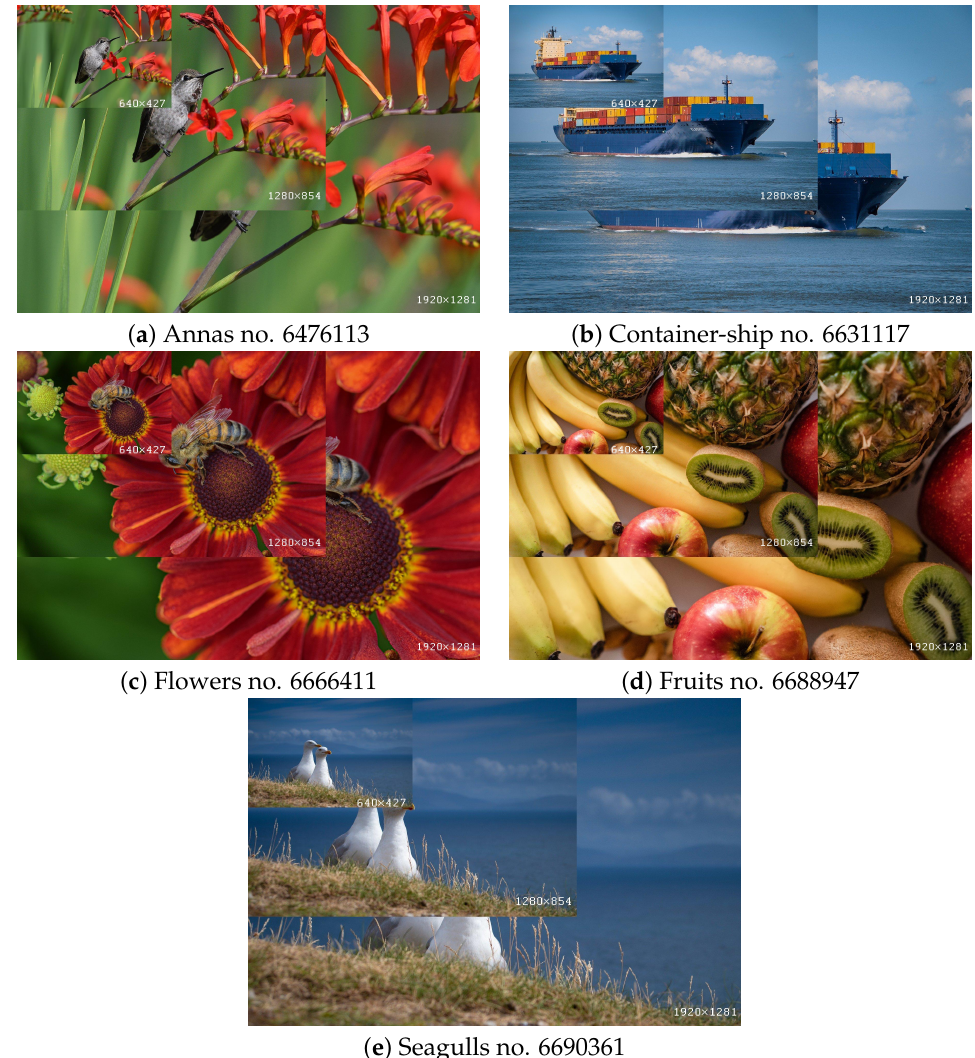
Figure 8. Selected Pixabay test images in three different resolutions: 640 × 427, 1280 × 854, and 1920 × 1281.